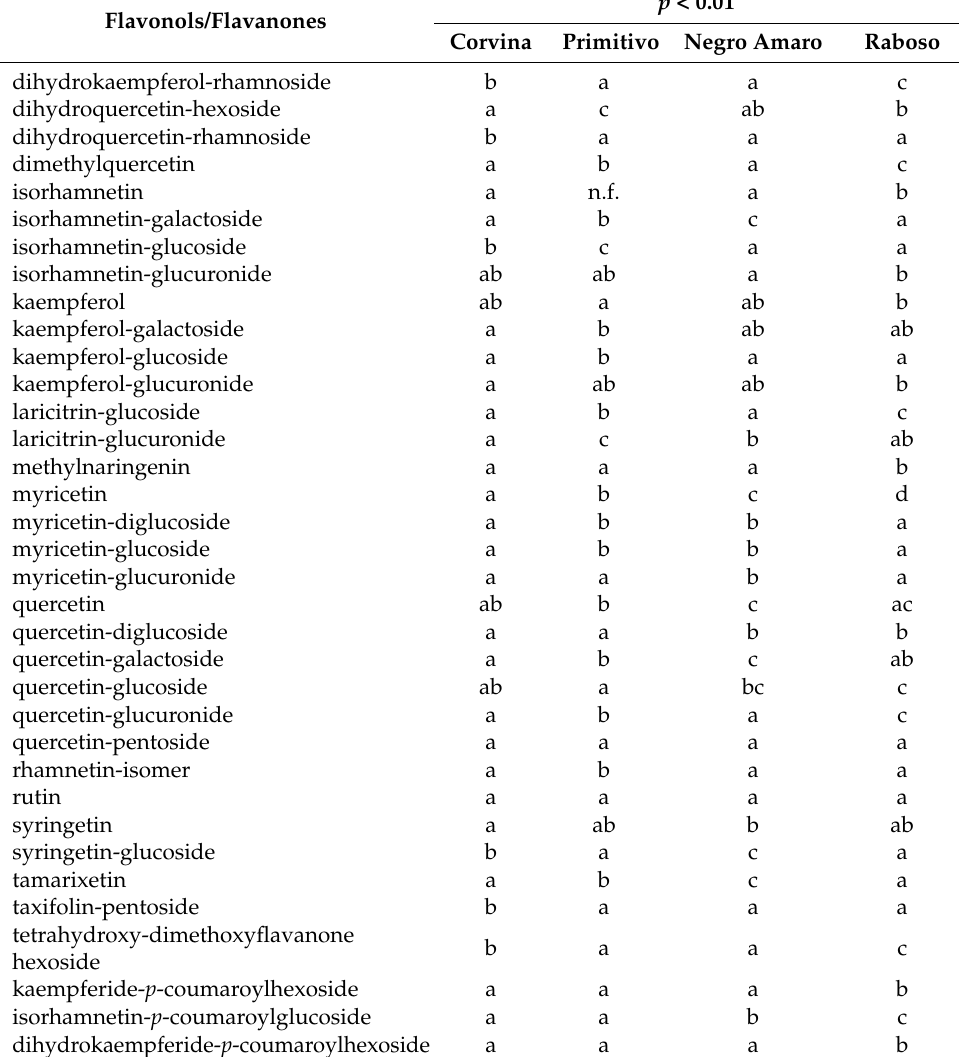
Table 1. Tukey’s test calculated using the normalized UHPLC-Q/TOF signal intensities of flavonols and flavanones identified in the four grape varieties ( n = 4). The data with different letters are significantly different for p < 0.01. n.f., signal not